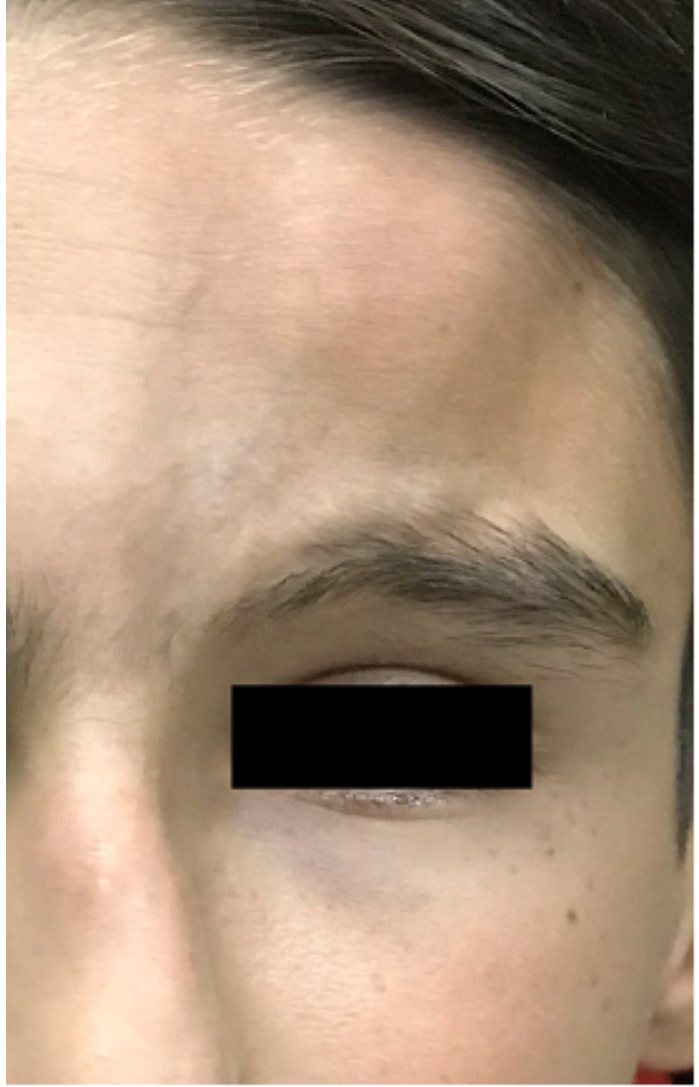
Figure 1. Photograph of the patient showing depressed left forehead skin lesion (en coup de